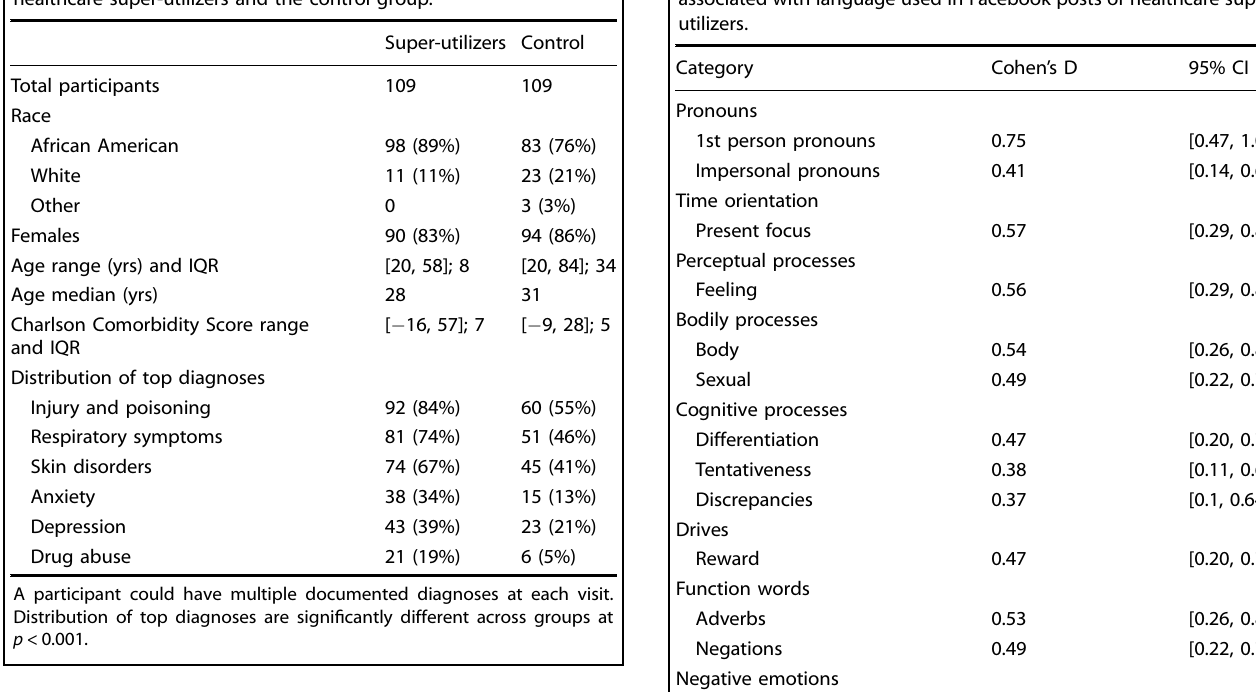
Table 1. Demographic characteristics and diagnoses distribution of healthcare super-utilizers and the control group.